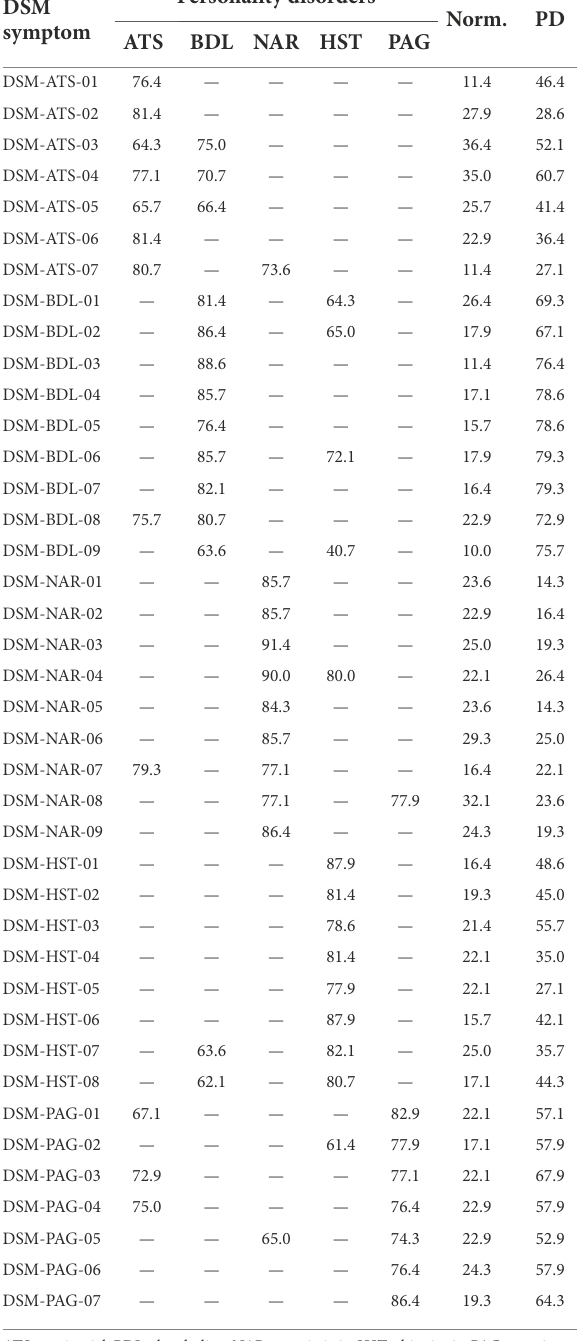
TABLE 1 Probabilities (%) of DSM symptoms for cluster-B personality disorders.